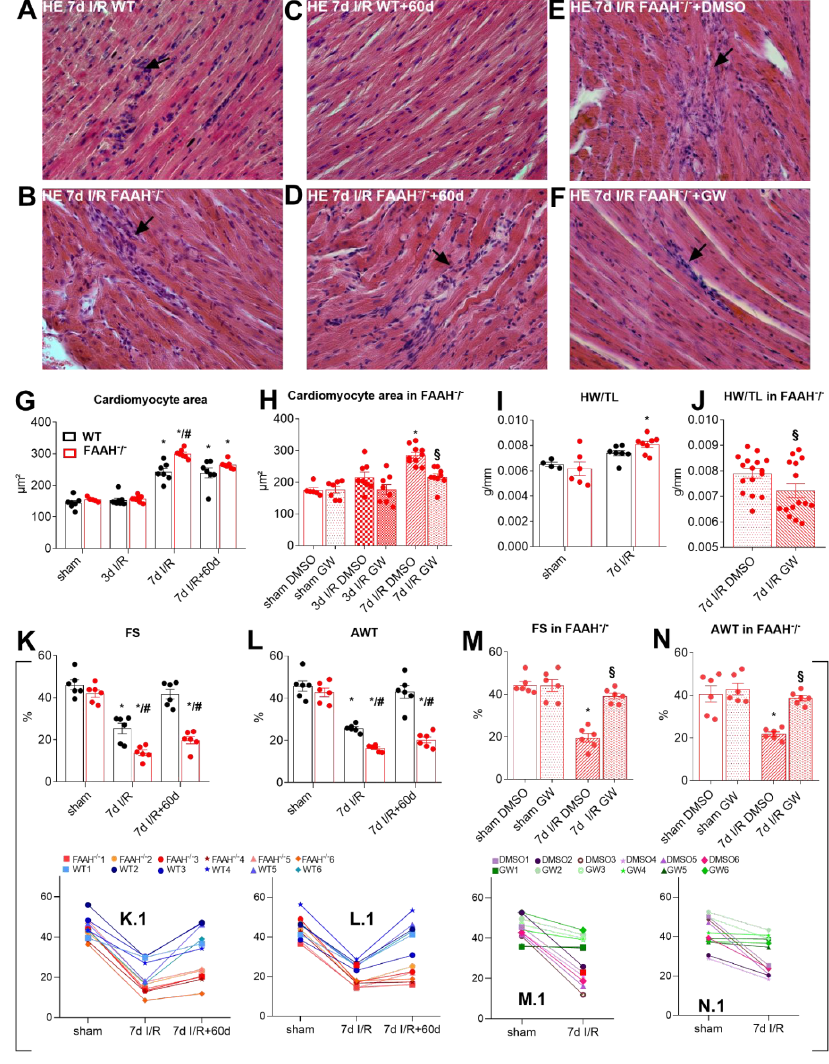
Figure 1. FAAH − / − mice show persistent cellular infiltration, cardiomyocyte hypertrophy, and loss of LV function after I/R, but recovery after PPAR- α inhibition with GW6471. Repetitive, brief I/R induced interstitial cellular infiltration (arrows) in ( A ) WT and in areas of cardiomyocyte loss ( B ) in FAAH − / − mice after 7d I/R as observed with hematoxylin and eosin staining. Panel ( C ) Shows recovery in WT after 60d, but persistent cellular infiltration in ( D ) FAAH − / − mice. ( E , F ) Recovery of FAAH − / − group after PPAR- α antagonism with GW6471 when compared to DMSO. ( G ) Increased cardiomyocyte area in FAAH − / − after 7d I/R and ( H ) decrease after GW6471 treatment. ( I ) HW/TL ratio showing increased hypertrophy in FAAH − / − group after 7d I/R, ( J ) normalizing after GW6471 treatment. Persistently reduced global and anterior LV function shown by ( K ) FS and ( L ) AWT in FAAH − / − was restored after GW6471 treatment ( M , N ). ( K.1 – N.1 ) show individual mouse data over time connected through different time points, allowing comparison of pre- and post-intervention values longitudinally. Magnification in ( A – F ): 400 × . AWT, anterior wall thickening; DMSO, Dimethyl sulfoxide; FAAH, fatty acid amide hydrolase; FS, fractional shortening; HE, hematoxylin eosin; HW/TL, heart weight/tibia length; WT, wild-type; *, p < 0.05 vs. respective sham; #, p < 0.05 FAAH − / − vs. WT at the respective time point; §, p < 0.05 FAAH − / − +GW vs. FAAH − / − +DMSO at the respective time